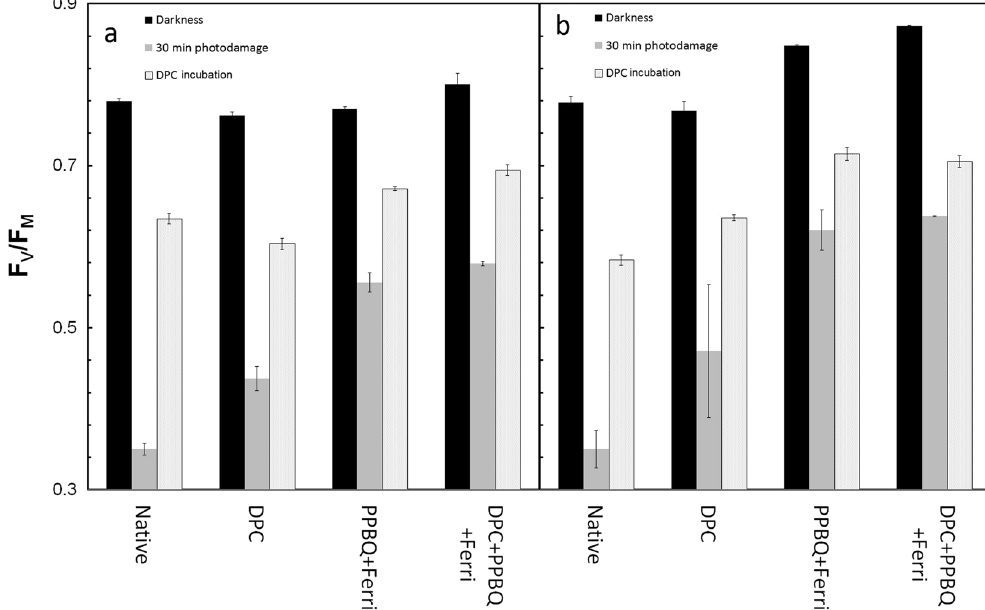
Figure 3. Comparison between the different treatments in the rescue experiments PSII activity in 460 nm experiments and PSII activity in the 660 nm experiments. ( a ) PSII activity in 460 nm experiments. ( b ) PSII activity in the 660 nm experiments. Average values ± standard error. For fluorescence measurements n =